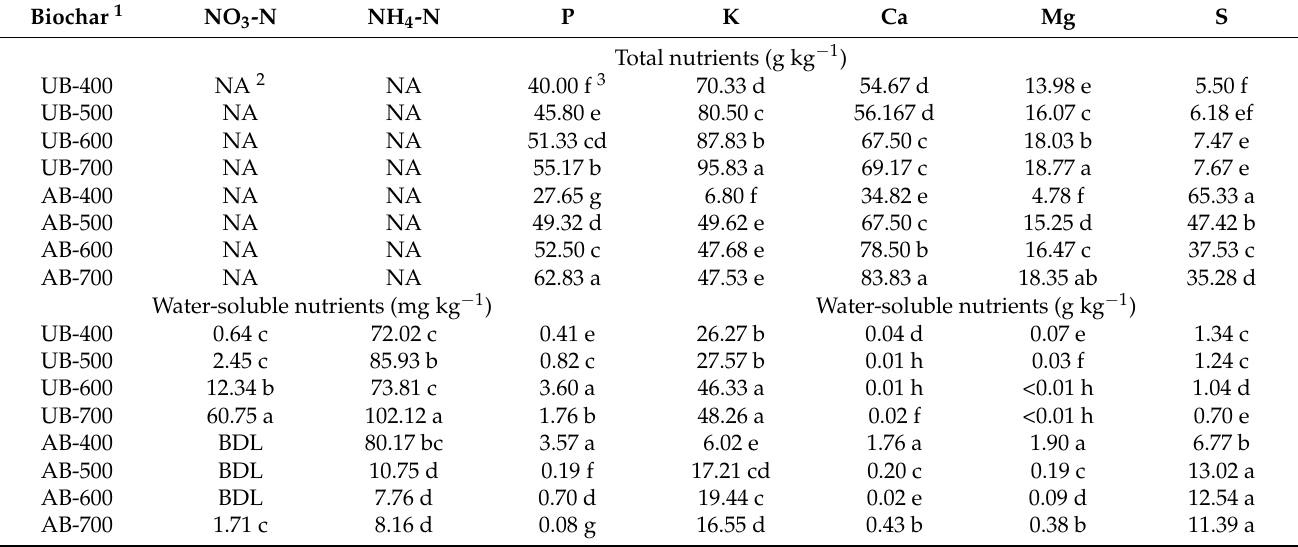
Table 3. Nutrient content (dry-weight basis) of biochar obtained from poultry litter at different temperatures (n